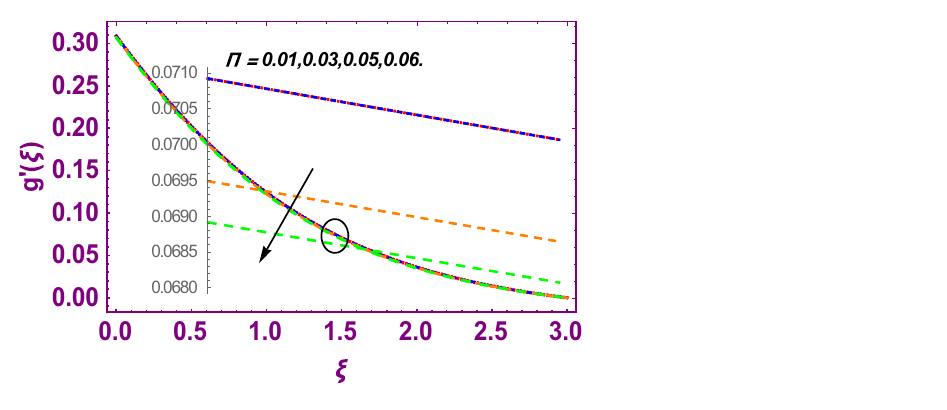
Figure 3. Effect of (cid:31) on g ′ (ξ)